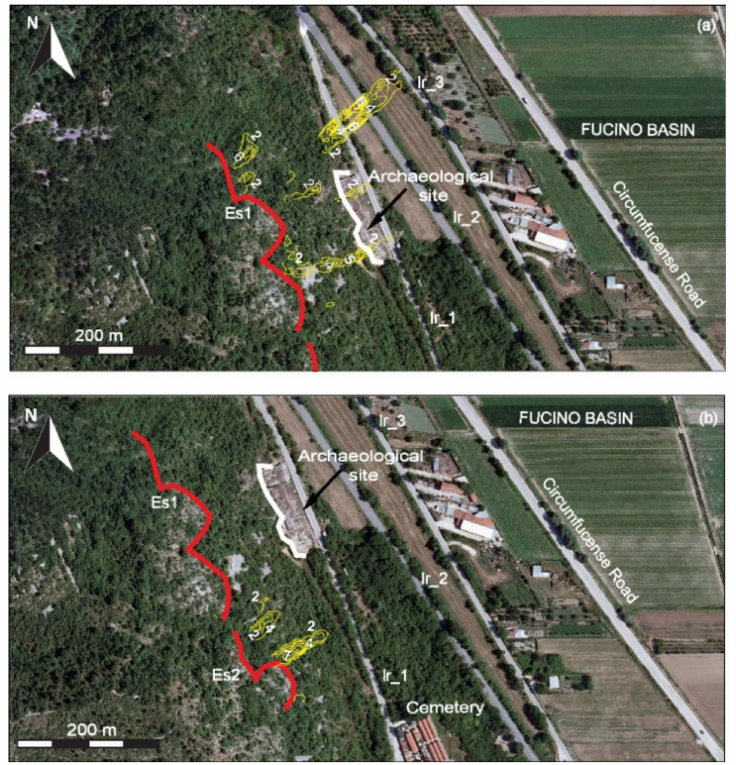
Figure 10. Bouncing heights map (m) for rockfall simulations from escarpment: ( a ) Es1; ( b )